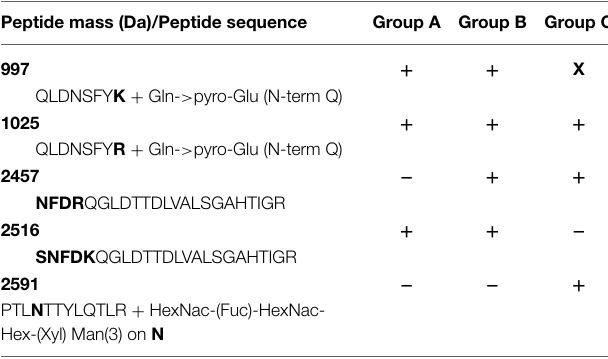
TABLE 4 | Characterization of three groups of peroxidase identified in the LiCl fraction of the hybrid protocol. Peptide mass (Da)/Peptide sequence